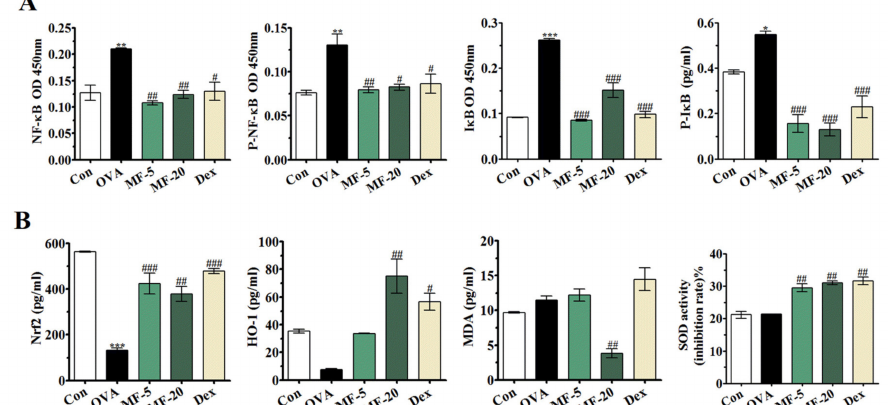
Figure 6. E ff ect of MF on NF- к B and Nrf2 / HO-1 signaling pathways in OVA-induced AR mice. ( A ) Detection of NF- κ B, P-NF- κ B, I κ B and P-I κ B in NALF. ( B ) Production of HO-1, Nrf2, SOD, and MDA in NALF. Values are presented as the mean ± SEMs ( n = 6 per group). * p < 0.05, ** p < 0.01, *** p < 0.001 , significantly di ff erent from the value of Control group. # p < 0.05, ## p < 0.01, ### p < 0.001 , significantly di ff erent from the value of OVA